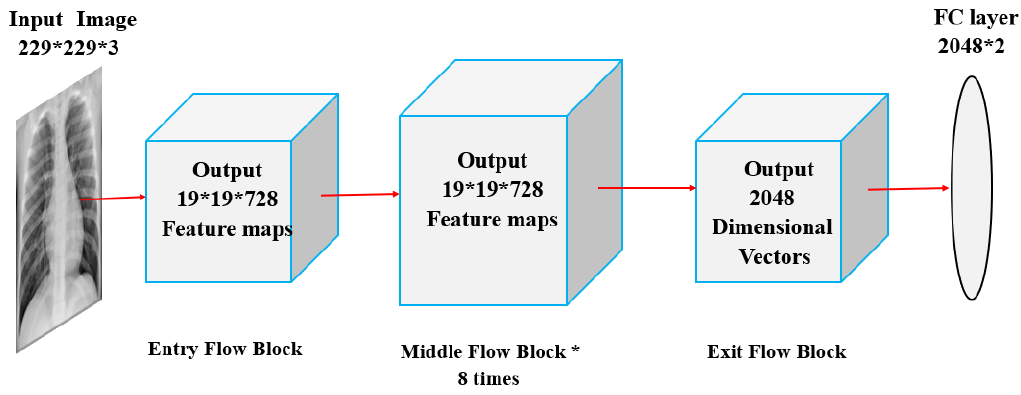
Figure A4. Xception architecture divided into three blocks: entry flow block, middle flow block, and exit flow